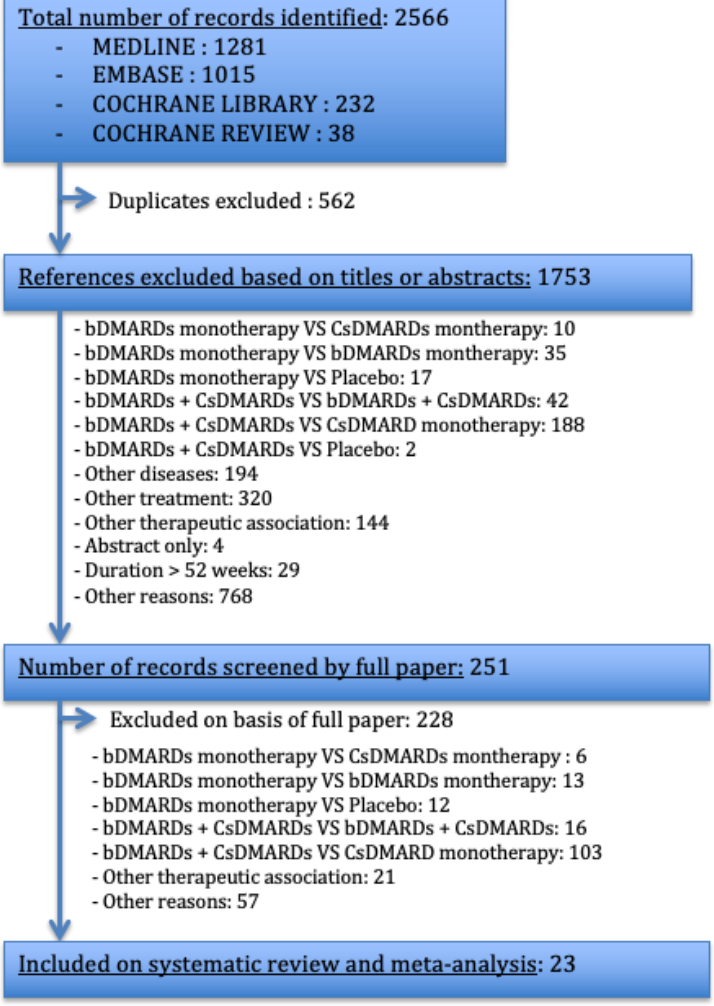
Figure 2. Flow diagram for study inclusion/exclusion. CsDMARDs: Conventional synthetic disease- modifying anti-rheumatic drugs; bDMARDs: Biological disease-modifying anti-rheumatic drugs; VS: versus.